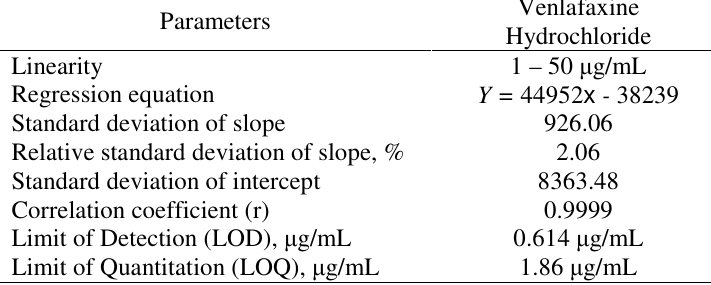
Table 1. Statistical data of calibration curves of esmolol hydrochloride.